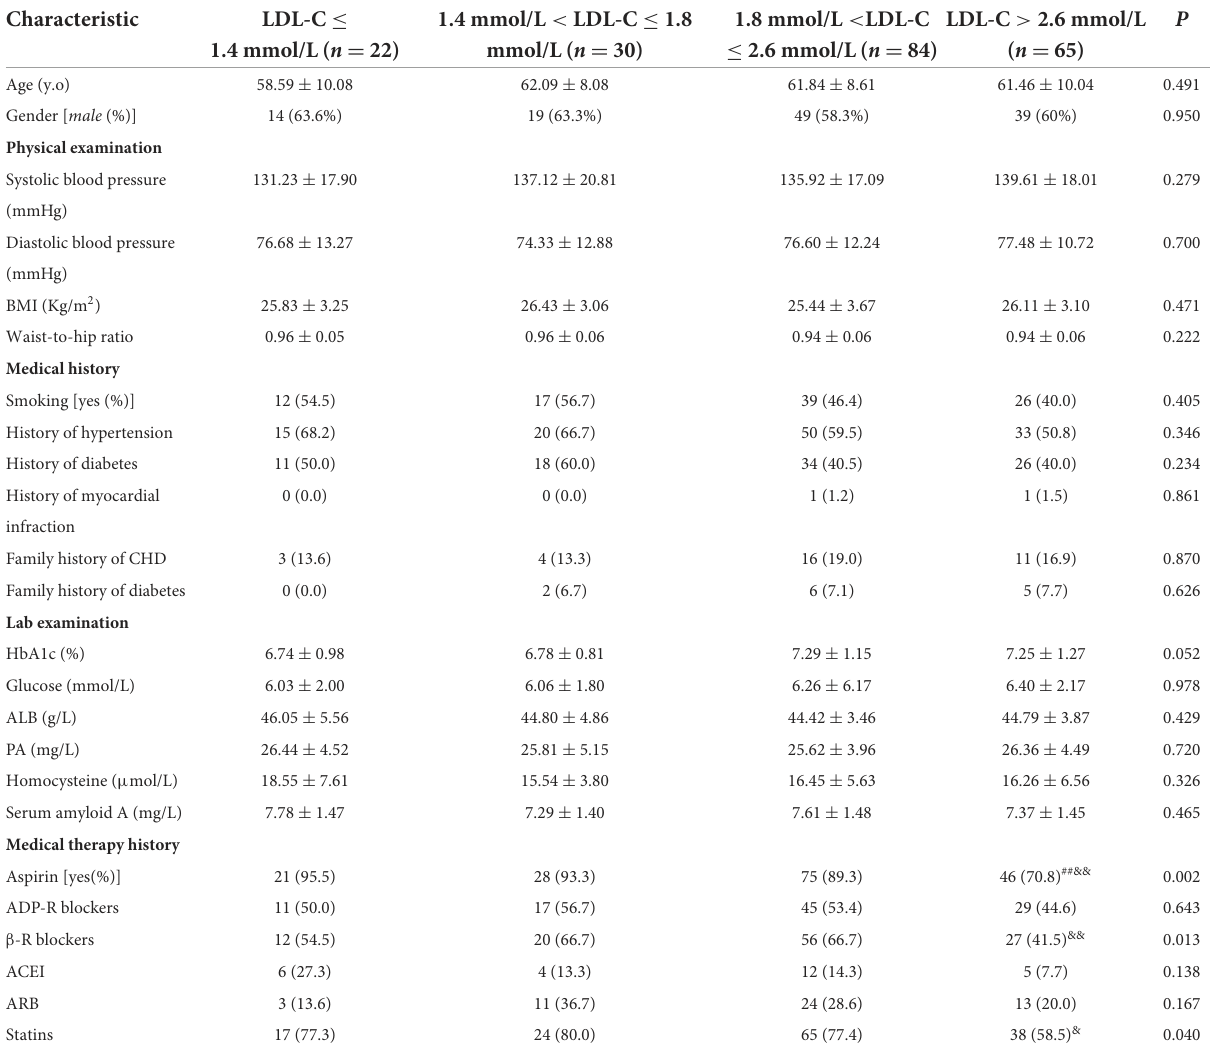
TABLE 1 Baseline characteristics of CHD patients with different LDL-C levels.